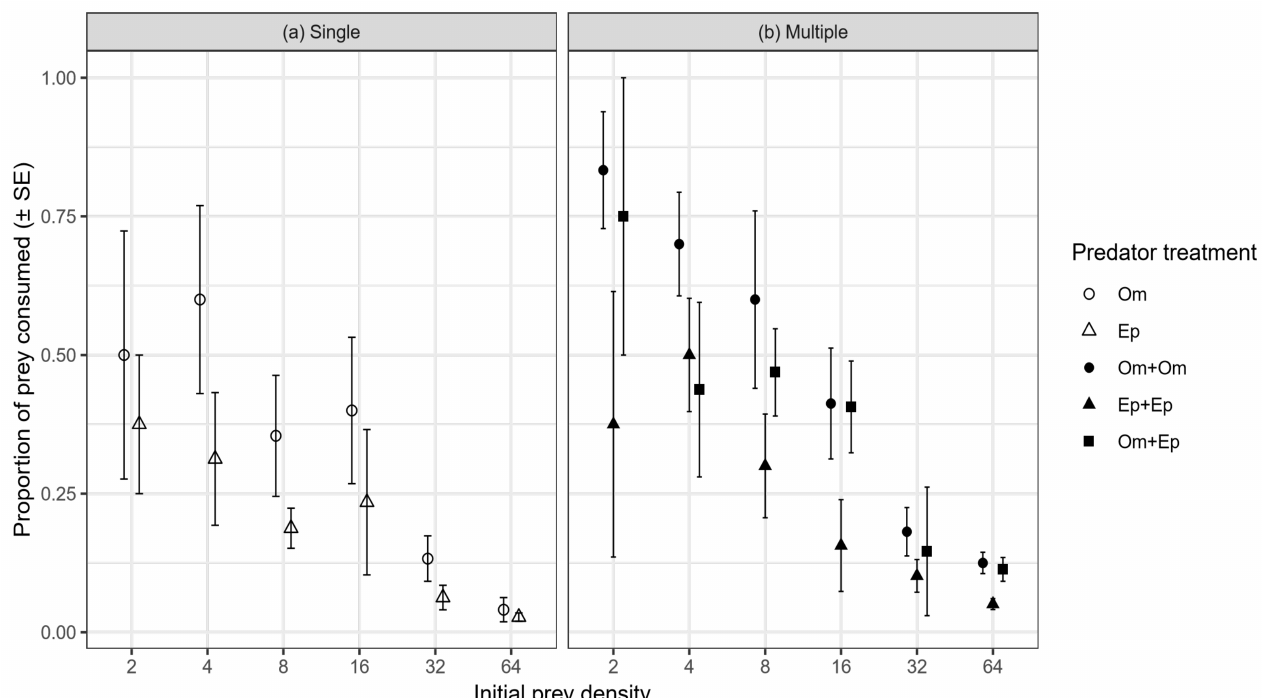
Figure 2. Mean ( ± SE) proportions of prey consumed by single ( a ) and multiple ( b ) preda- tor groups according to predator treatment and prey density. Om = Oreochromis mossambicus , Ep = Enteromius paludinosus